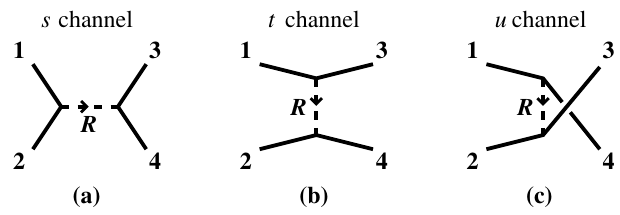
Figure 4 . Three ways to form bases for 4-gluon color singlet states. (The terms s -channel, etc. are merely evocative here; we are not referring to 2 ↔ 2